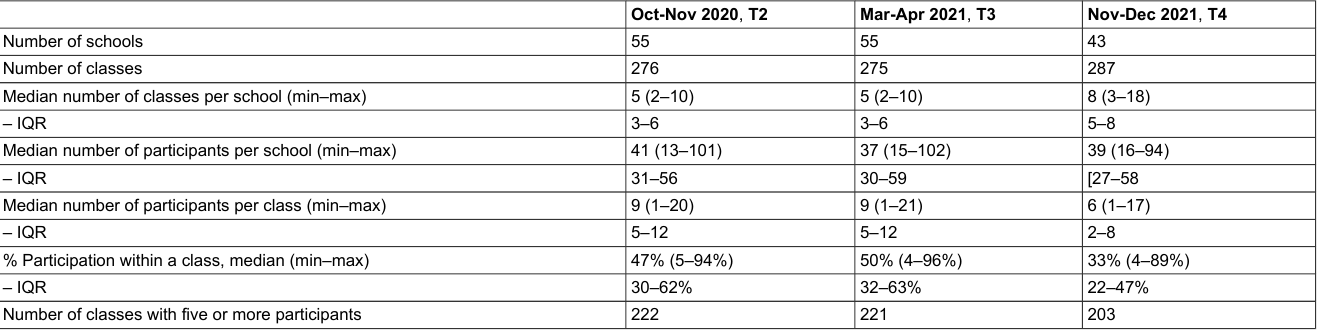
Table 2: Participation rates and school-level characteristics of the Ciao Corona study at T2, T3 and T4.